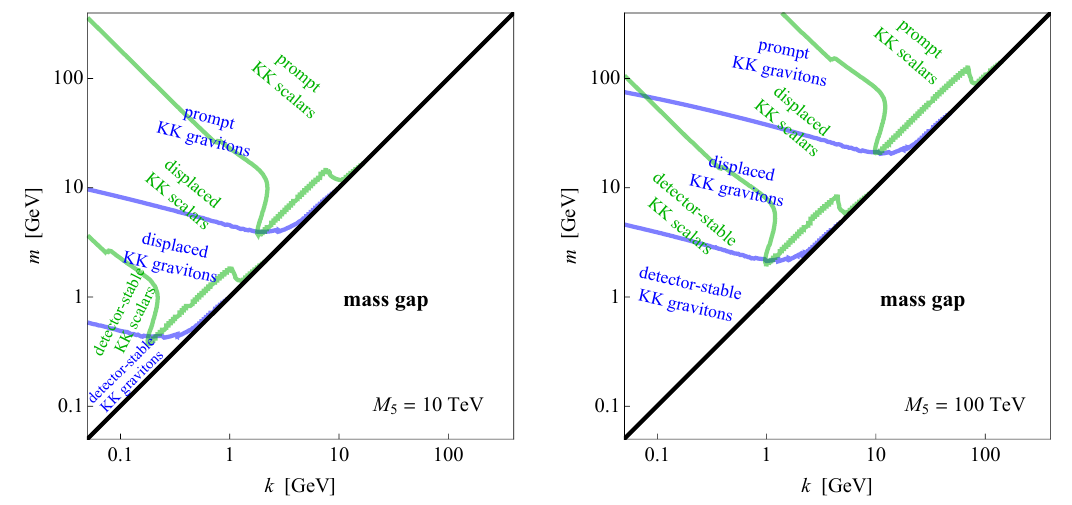
Figure 8 . Mass ranges in which the KK gravitons (blue) or KK scalars (green) are detector- stable, displaced, or prompt, for M 5 = 10 TeV (left) and 100 TeV (right), as functions of k . The boundaries between detector-stable/displaced/prompt were de(cid:12)ned as c(cid:28) = 10 m and 1 mm. For the KK scalars, the results are presented for the case of rigid boundary conditions and vanishing curvature-Higgs interaction from eq. (2.55).